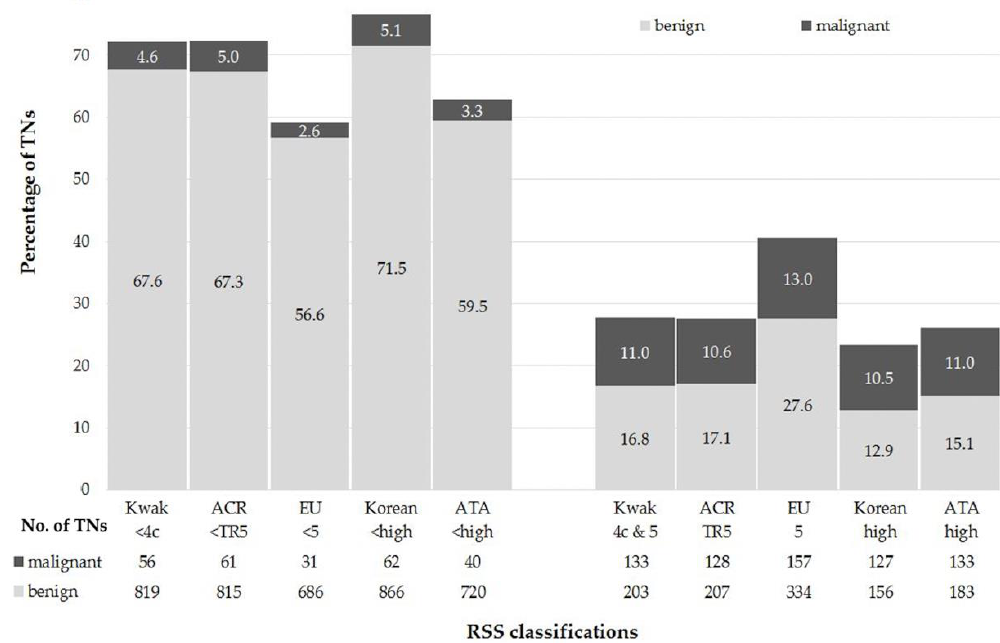
Table 4. Diagnostic performance parameters of the ultrasound risk stratification system (RSSs) for the differentiation be- tween benign and malignant thyroid nodules (TNs). Diagnostic Param- eters